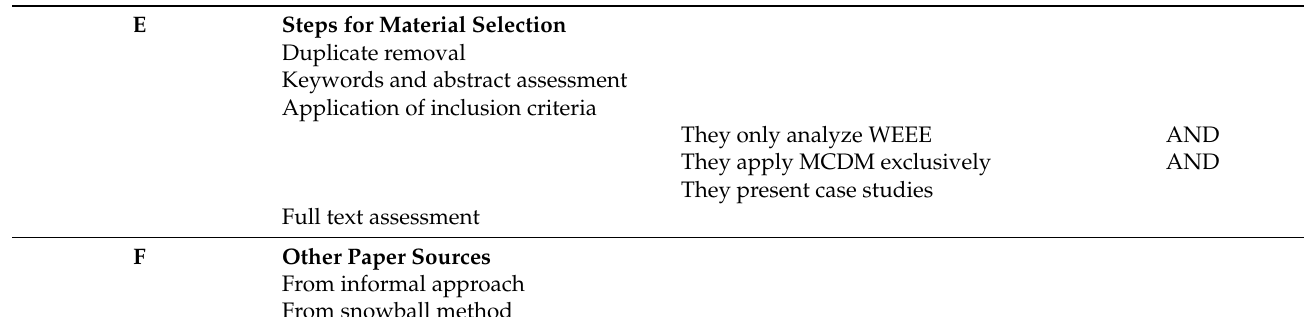
Table 2. Selection phase approach.